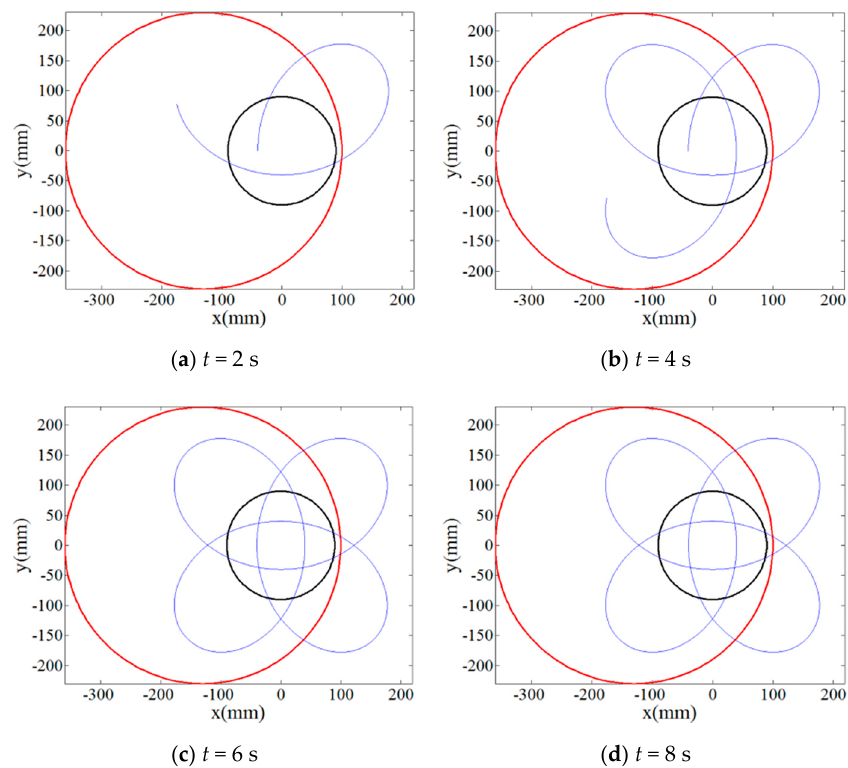
Figure 3. Relationship between trajectory of the single abrasive particle on target surface at i pw = 4/3 and lapping time ( a ) t = 2 s; ( b ) t = 4 s; ( c ) t =6 s; ( d ) t = 8 s.